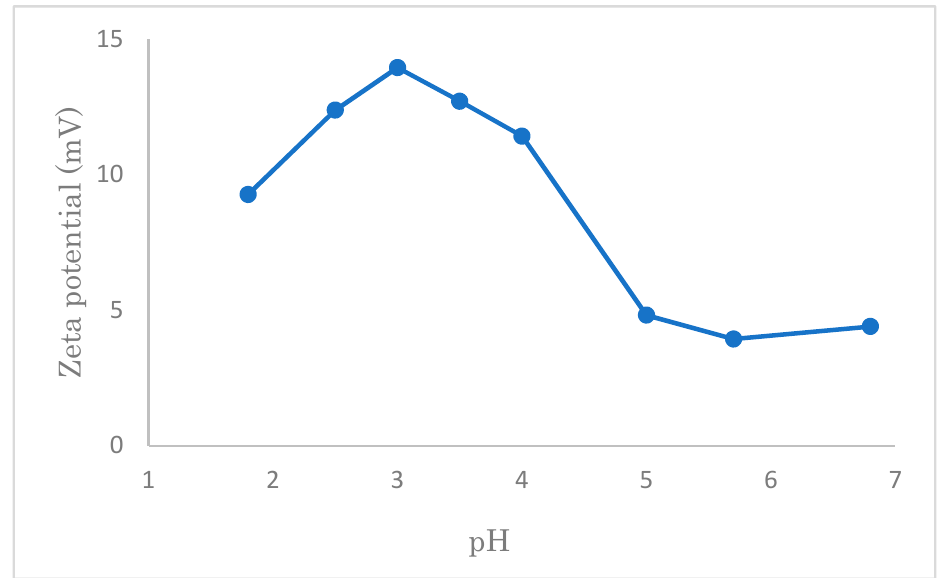
Figure 16. Zeta potential of modified cellulose (in 0.01 mol/L NaCl) at different pH.